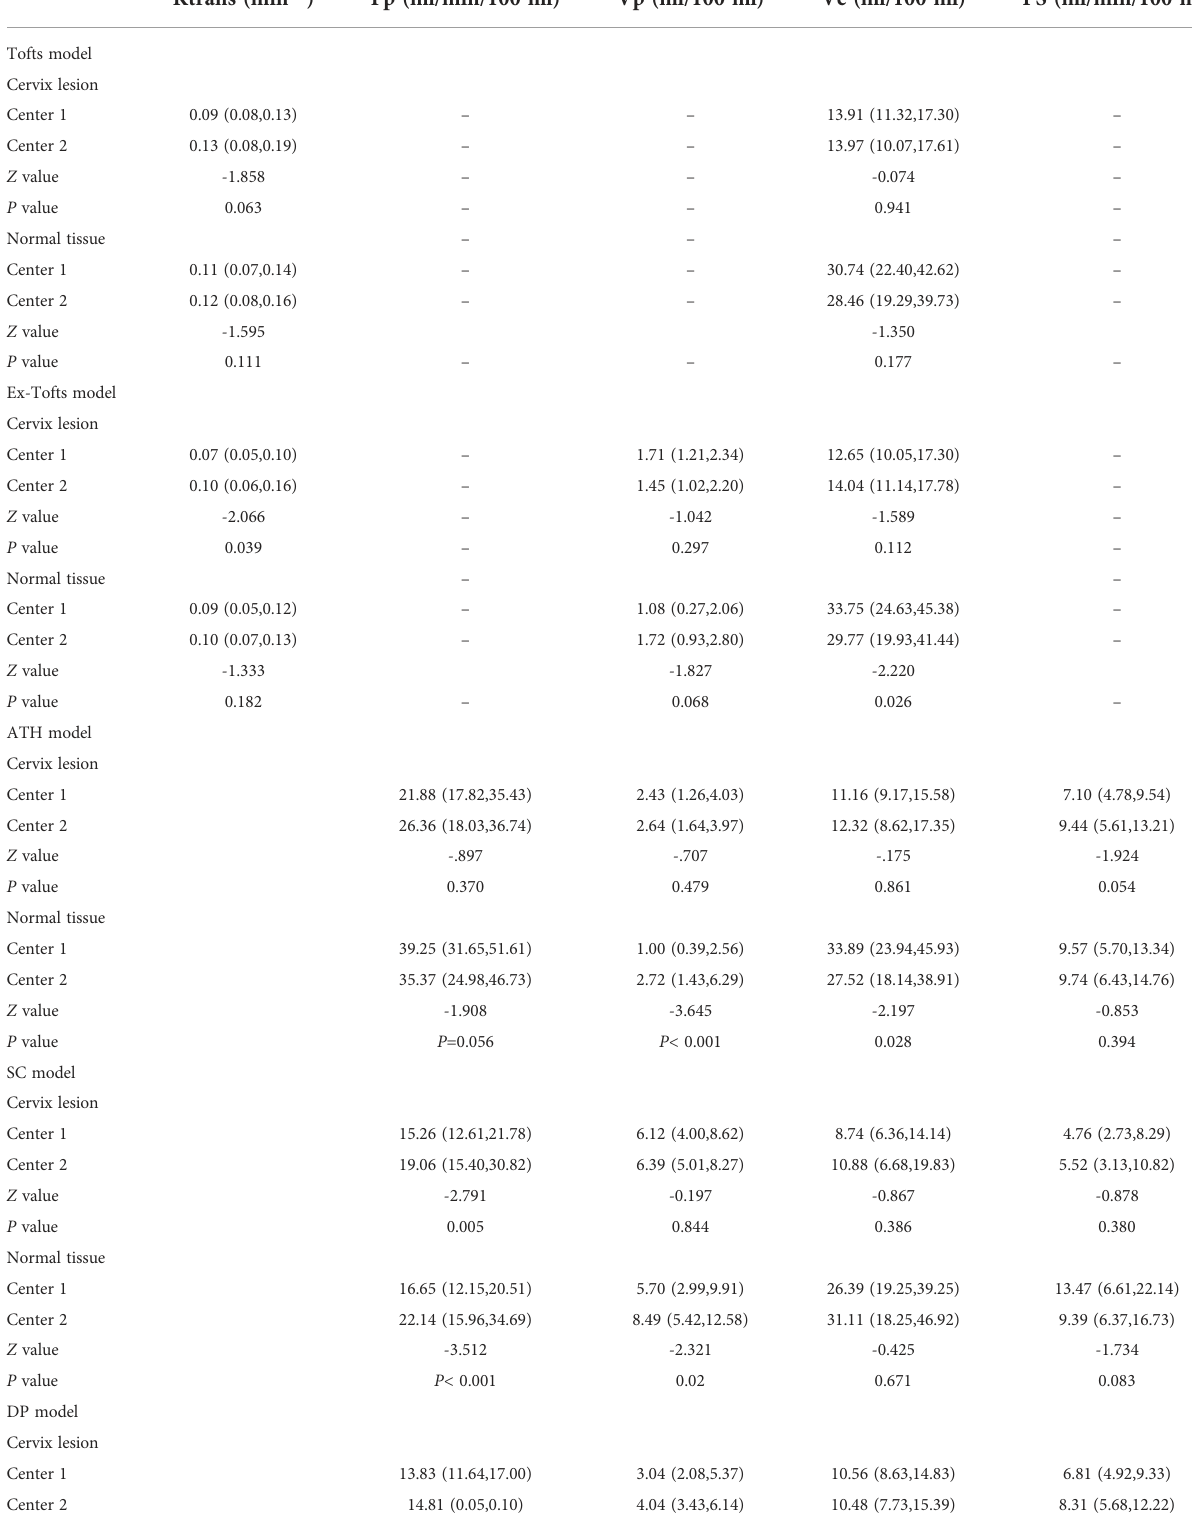
TABLE 5 Measured values (median and inter-quantile range in the bracket) of DCE kinetic parameters (Ktrans, Fp,Vp, Ve, PS) derived from (Tofts, Ex-Tofts, ATH, SC, and DP models) in cervical cancer and normal cervix tissue, and the corresponding p-values of Mann – Whitney U